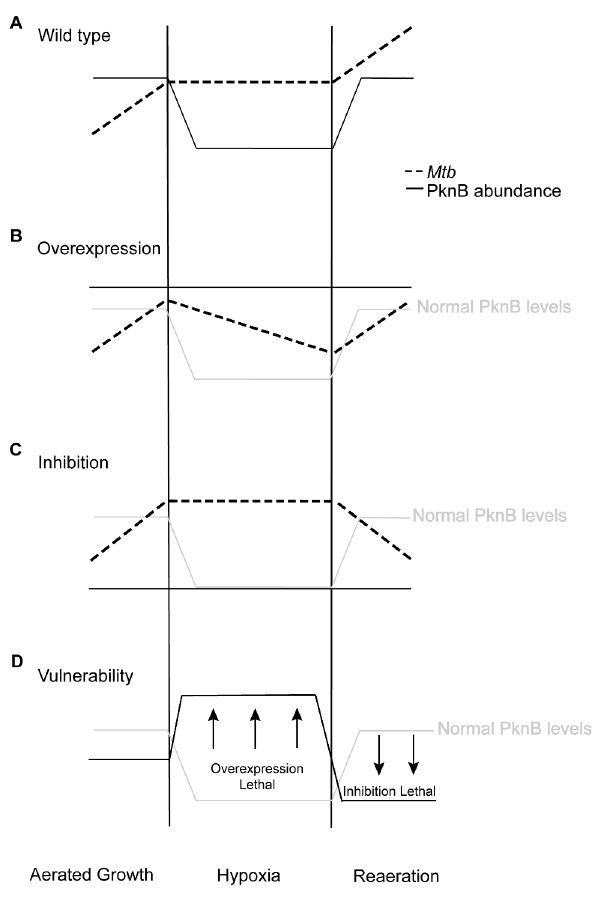
Figure 8. Effects of PknB dysregulation in hypoxia and reaeration. (A) Mtb growth (dashed line) is regulated by PknB (solid line) in response to oxygen tension. Under low oxygen conditions in hypoxia, PknB activity is decreased to facilitate growth arrest, but returns upon reaeration to support regrowth. PknB dysregulation by (B) overexpression or (C) inhibition interferes with survival at different stages. (D) Mtb growth is most vulnerable to PknB targeting in hypoxia and reaeration. Elevated PknB levels in hypoxia and reduced levels in reaeration are most detrimental.